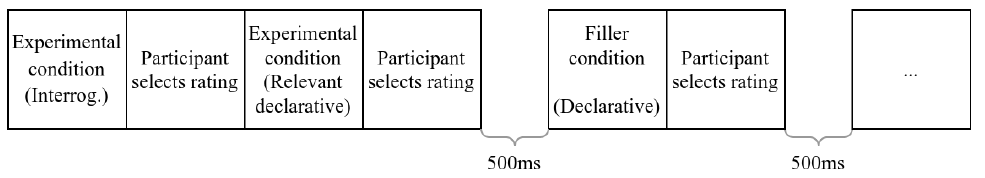
Figure 5. Trial order structure in Experiment 2, highlighting placement of 500 ms